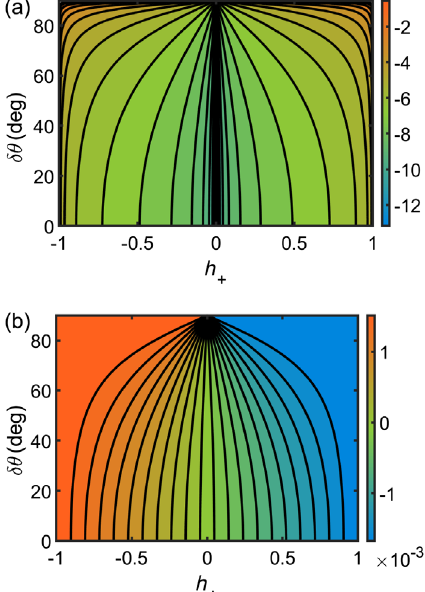
FIG. 5. (a) Surface plot in the ð h þ ; δθ Þ plane of Þ(cid:3) evaluated on the optical axis in a log ½ max ð F reac χ Þ = max ð F inter purely dissipative chiral force configuration. (b) Surface plot in Þ evaluated on the the ð h þ ; δθ Þ plane of max ð F diss χ Þ = max ð F inter optical axis in a purely dissipative chiral force configuration. In both reactive and dissipative couplings, δθ and h þ are chosen in order to maximize the ratio of chiral vs interferential forces while keeping the interferential forces sufficiently weak as to ensure the double-well structure described in Fig. 3. For these calculations, the intensities in the two beams, the wavelength, and the nano- sphere dipolar polarizability are the same as in Fig. 3. We set the chiral polarizability χ = α ¼ 5% as we discuss in Appendix